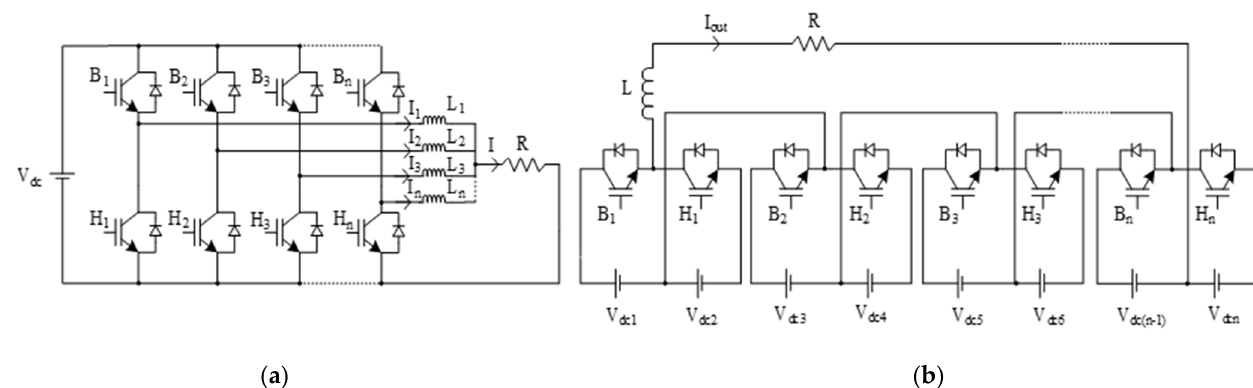
Figure 1. Multicellular converters, ( a ) multiphase converter [1,2]; ( b ) multilevel converter [3,4].